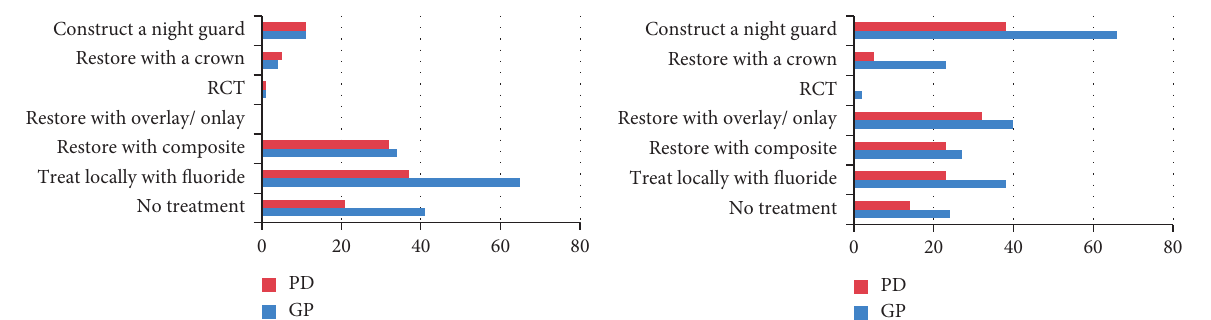
Figure 6: Frequencies of treatment decisions among GPs (general practitioners) and PDs (prosthodontists). Table 4: The frequency of treatment decisions and ( n ) the number of GPs and PDs responding to each treatment option on clinical case two. Treatment decision